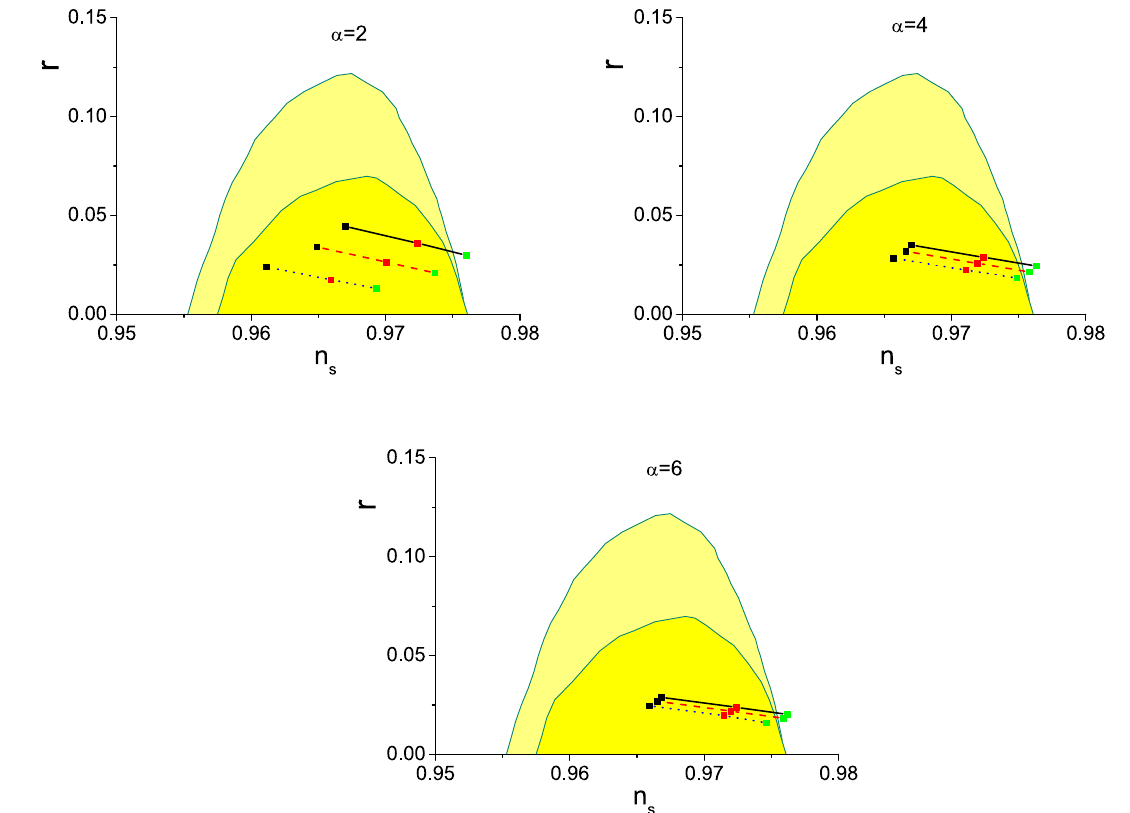
Fig. 2 1 σ (yellow) and 2 σ (light yellow) contours for Planck 2018 results (Planck + TT + lo w P ) [78], on the n s − r plane. Furthermore, we depict the predictions of Table 1, of the scenario at hand for various valuesofthethenon-canonicalparameter α andthedeformed-steepness parameter n , keeping fixed M = 10 − 6 M pl and V 0 = 10 − 16 M 4 M pl = 10 18 GeV, determining the value of λ through the observational